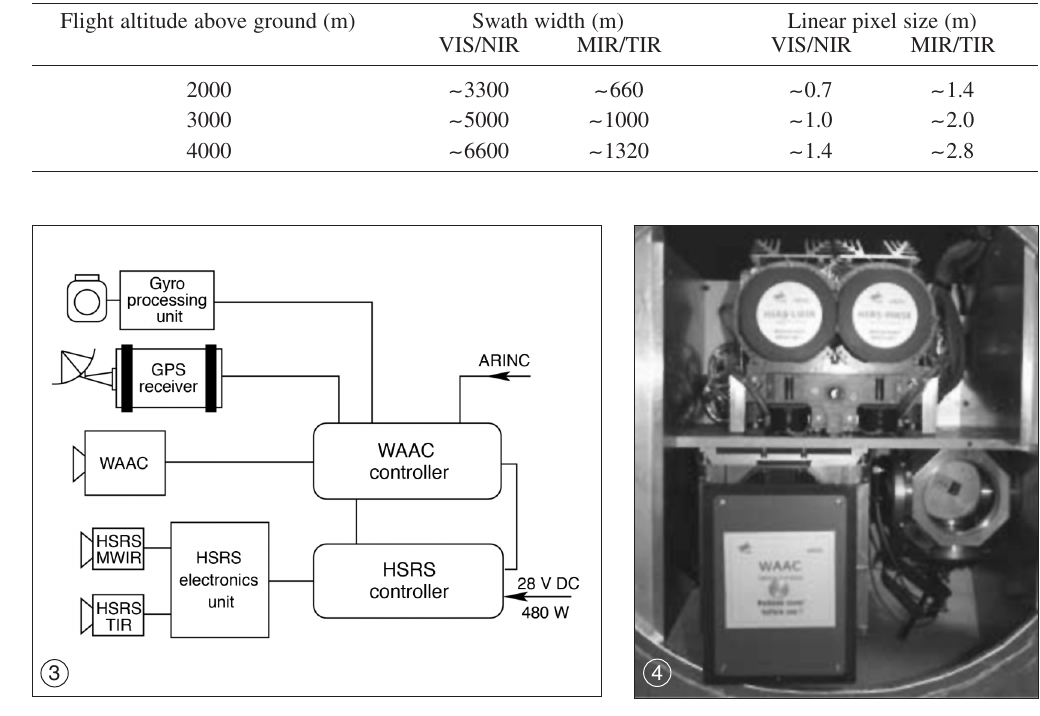
Fig. 3. Block diagram of the BIRD airborne simulator. Fig. 4. ABAS sensor